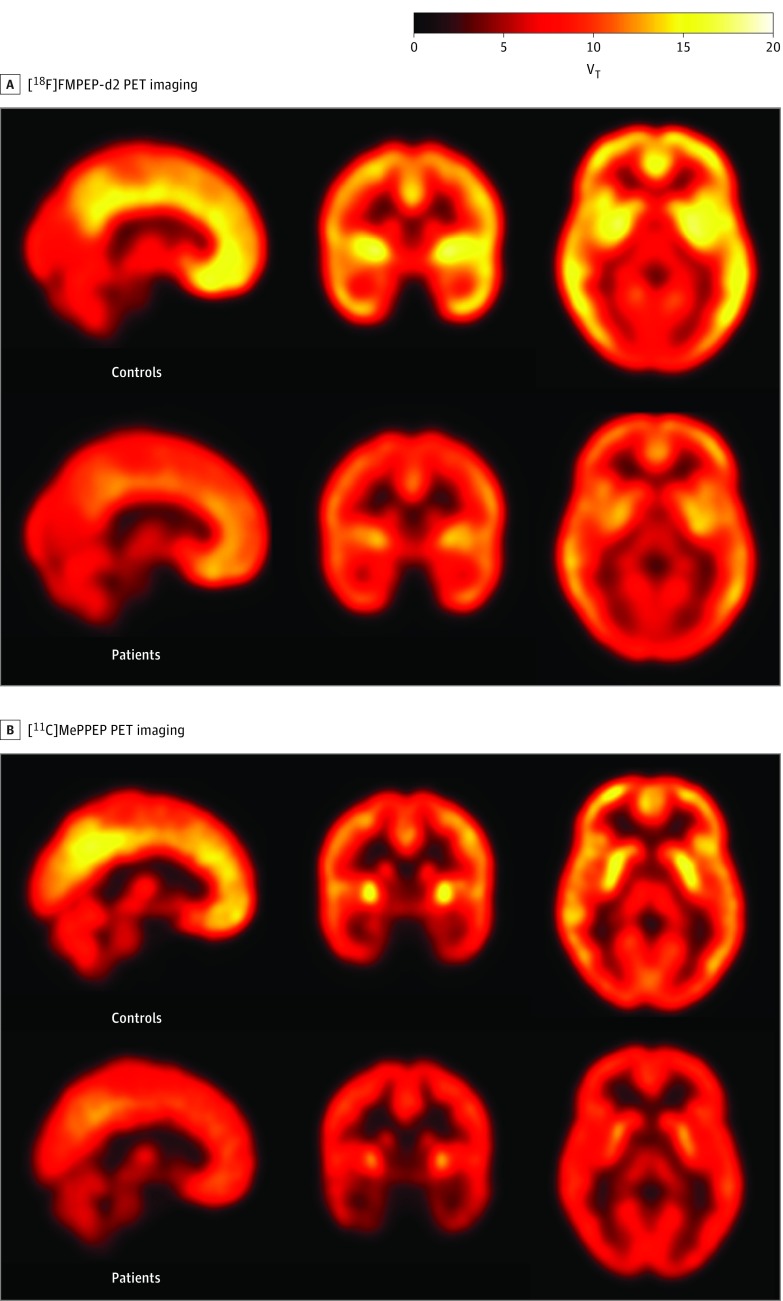
Cannabinoid 1 Receptor Availability Measured Using Positron Emission Tomographic (PET) ImagingCannabinoid 1 receptor availability was significantly lower in patients with first-episode psychosis relative to healthy volunteers as determined by the distribution volume (VT; measured in milliliters per cubic centimeter) of radiotracers fluoride 18–labeled FMPEP-d2 (F1,16 = 19.84; P < .001) and carbon 11–labeled MePPEP (F1,38 = 4.96; P = .03). Images are mean parametric maps for controls (top row of A and B) and patients (bottom row of A and B) in each respective study. Brain regions with relatively higher distribution volumes of the respective radiotracer are shown in yellow.